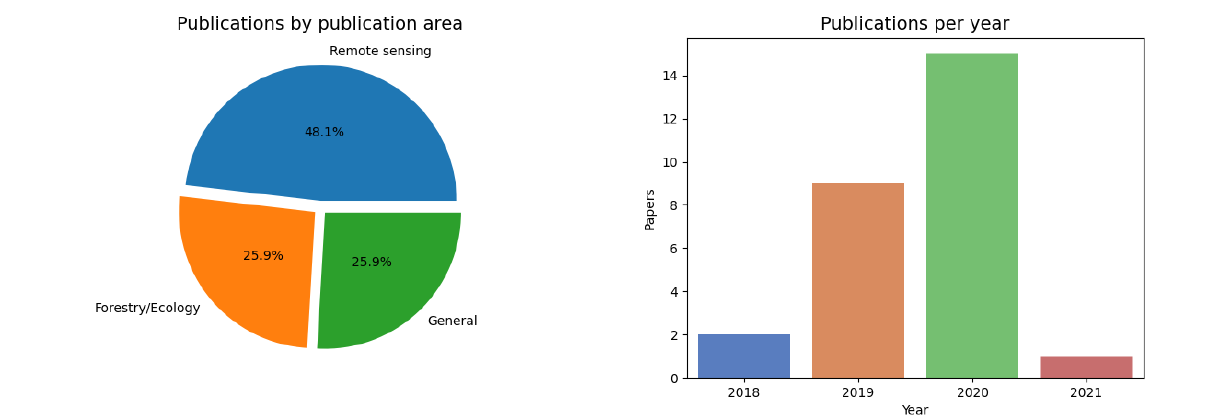
Figure 1. Charts of the distribution of papers by publication type and year of